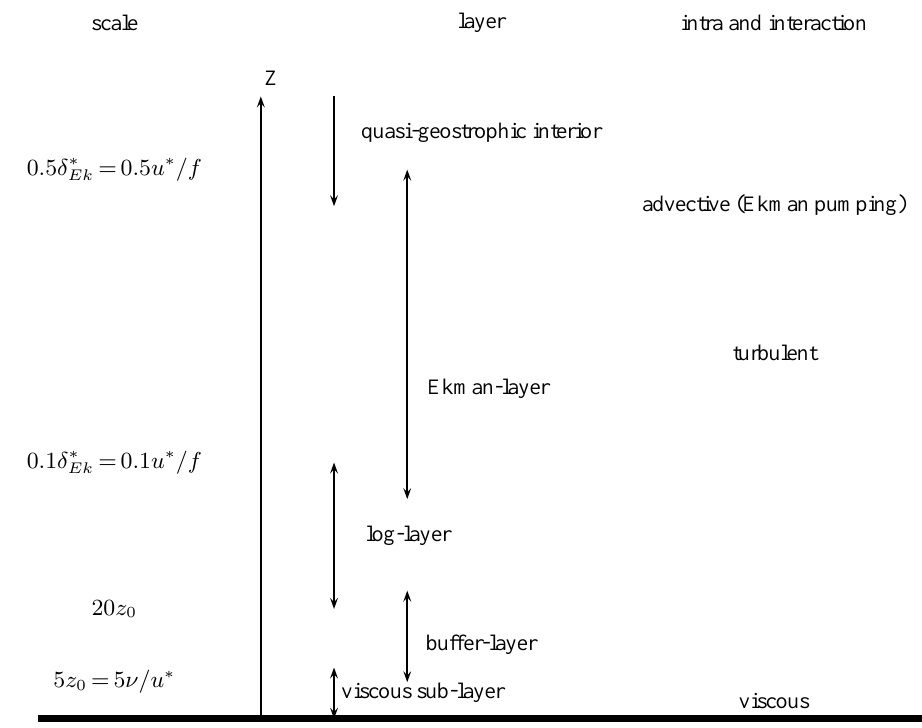
Fig. 2. Sketch of the composition (sub-layers) of the turbulent planetary boundary layer. The thick horizontal line is the ocean floor; the distance from the ocean floor is given by the Z-coordinate. The extension of the different sublayers are given in the middle column; the extension of the layers in terms of the physical parameters is given in the left column. The important processes in the intra and interaction of layers is given in the right column.